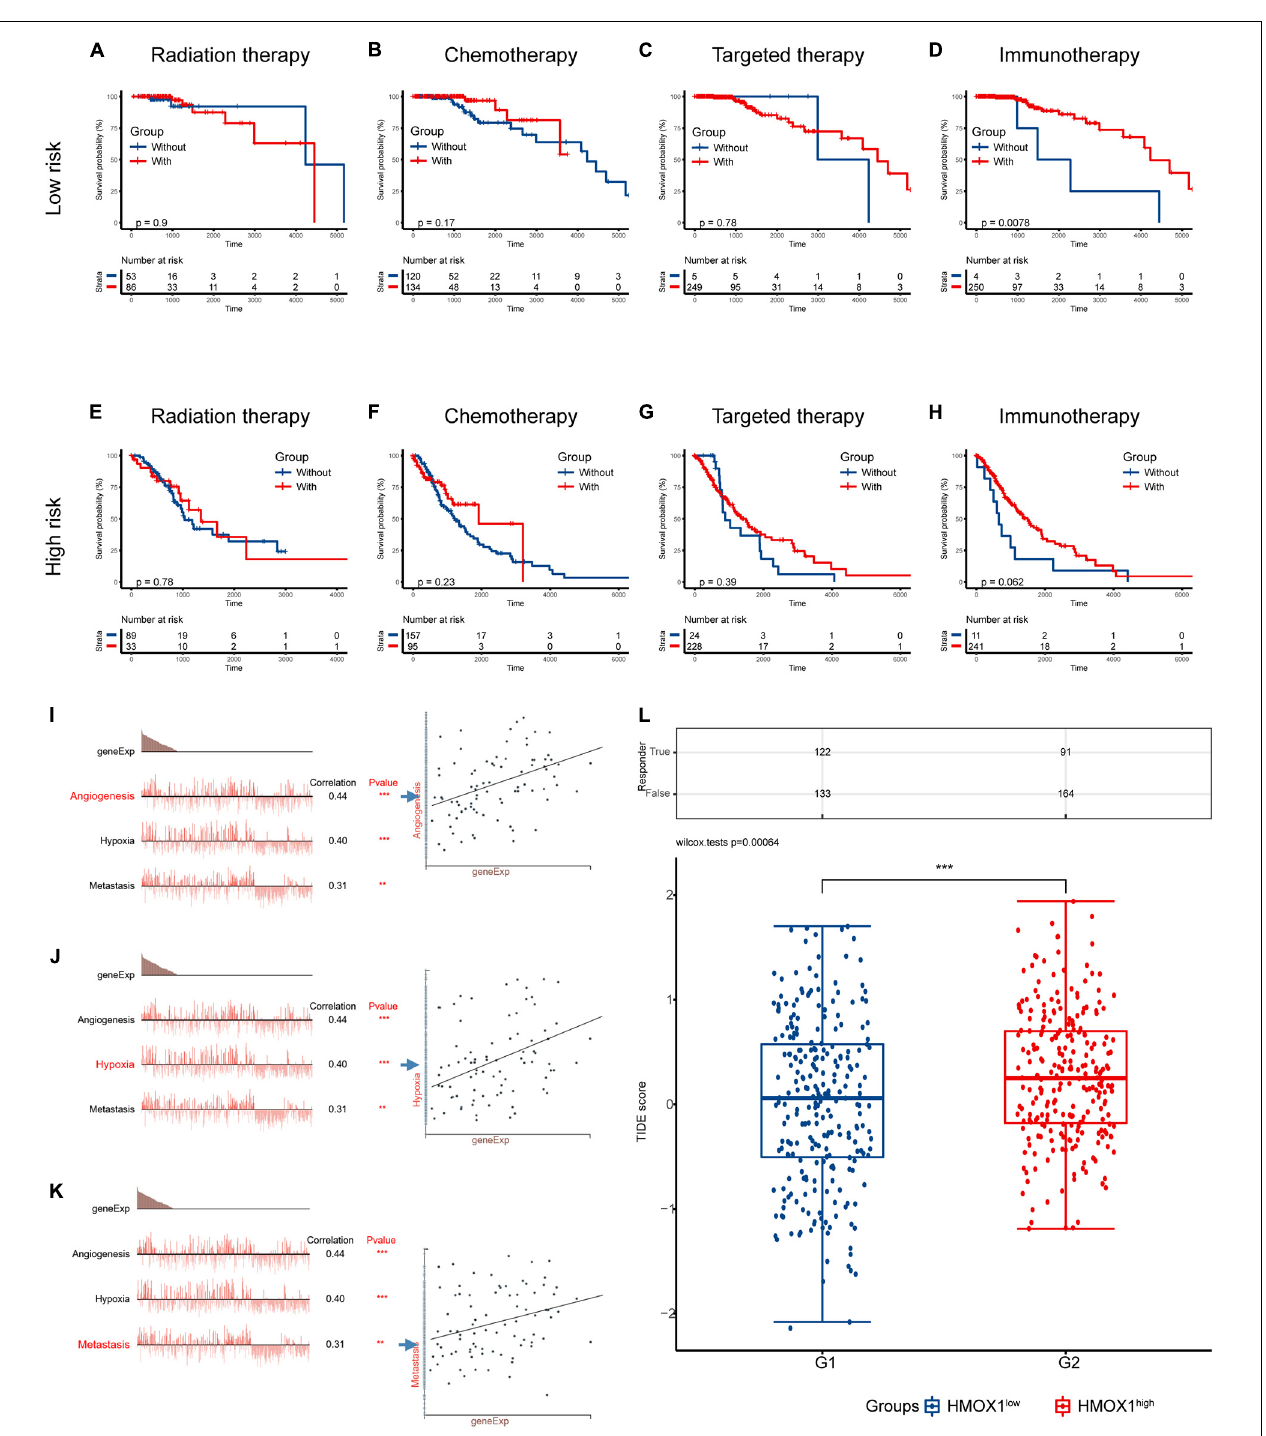
FIGURE 8 | Validation using collected samples and prediction of therapy efficacy. (A–D) The efficacies of radiation therapy, chemotherapy, targeted therapy, and immunotherapy in the TCGA cohort. (E–H) The efficacies of radiation therapy, chemotherapy, targeted therapy, and immunotherapy in the CGGA cohort. (I–K) The relationship between functional states and HMOX1 expression based on single-cell sequencing. (L) Prediction of response to immunotherapy using TIDE algorithm. ** p < 0.01, *** p < 0.001. TIDE, Tumor Immune Dysfunction and Exclusion.